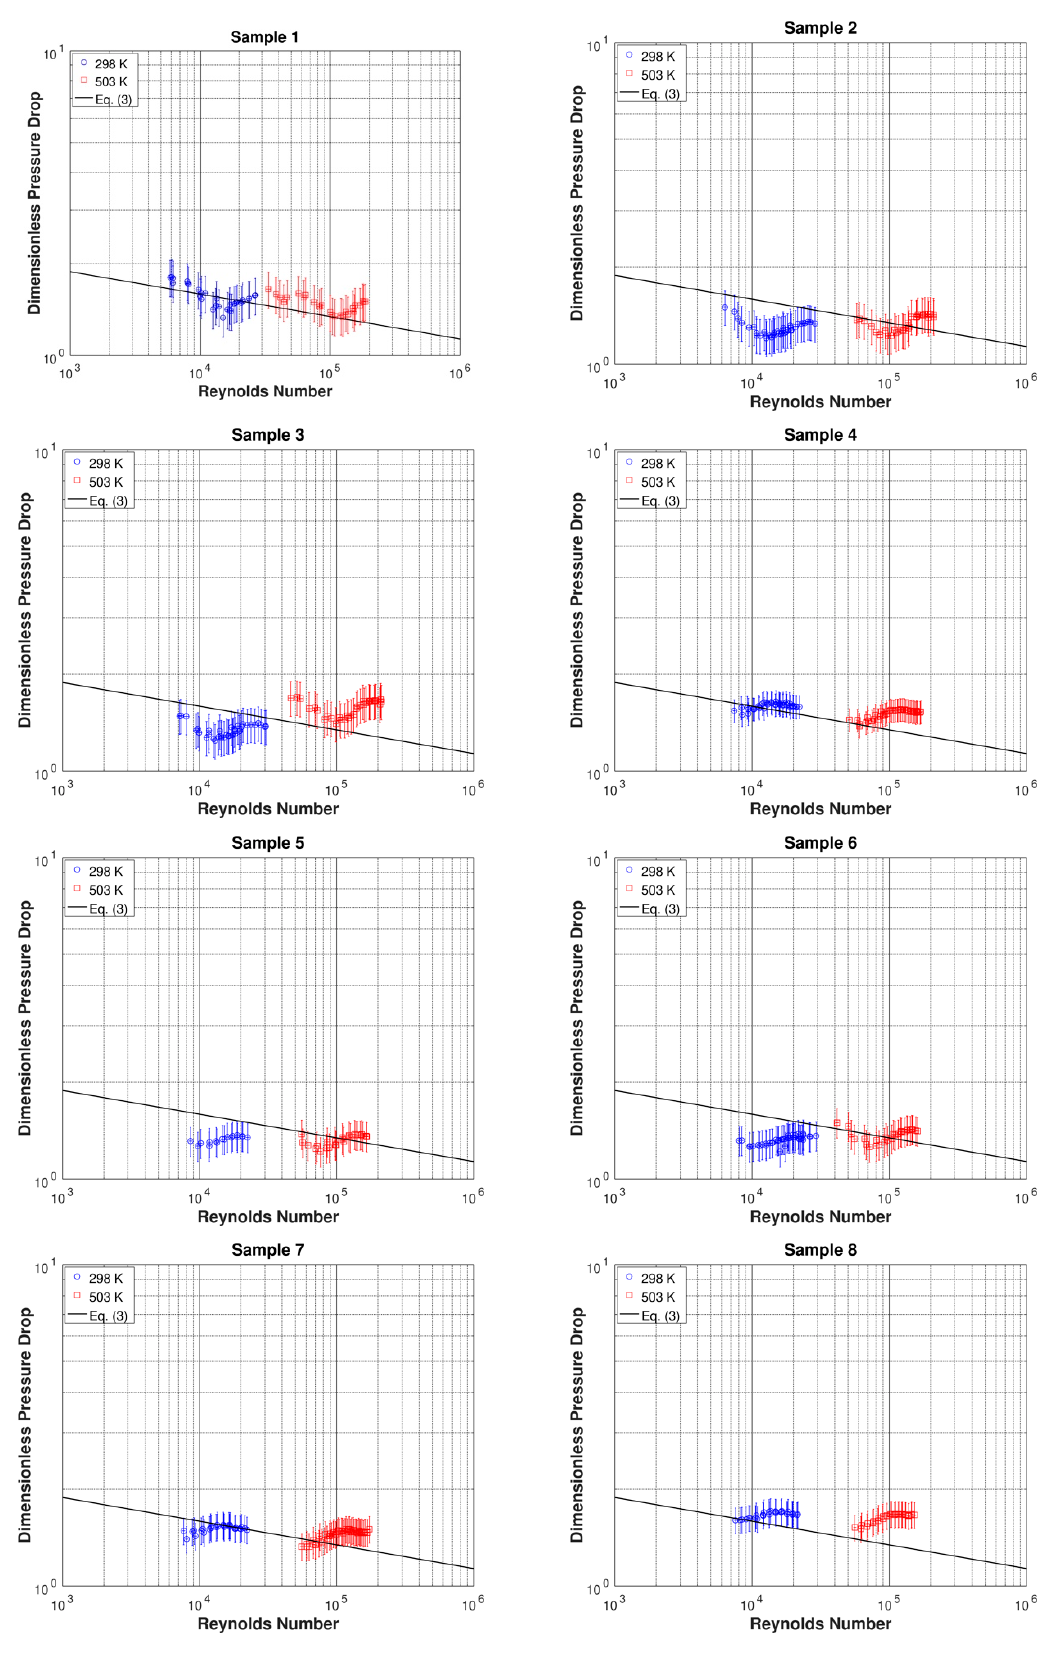
Figure 4. Dimensionless pressure drop as a function of Reynolds number for the micro-orifices tested.